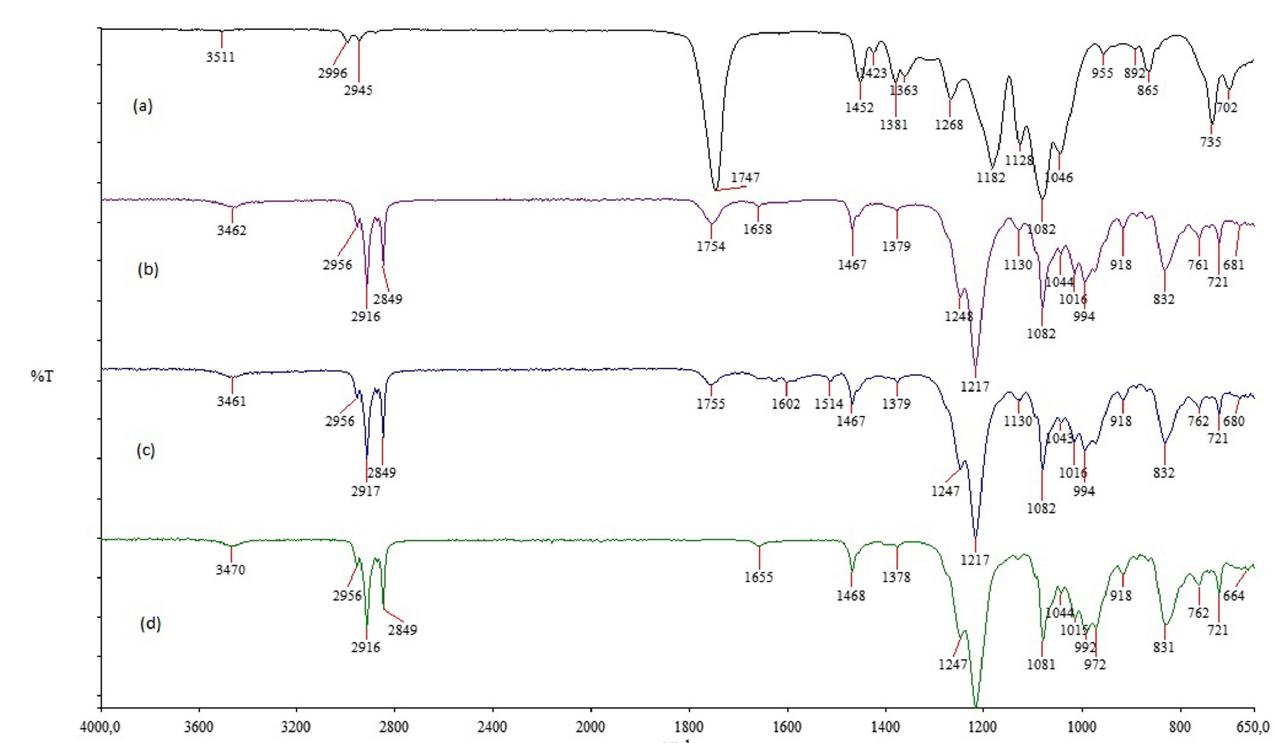
FIGURE 1 - ATR-FTIR spectra of the PLGA (a), blank nanoparticles (b) curcumin-loaded nanoparticles (c) and SDS (d).